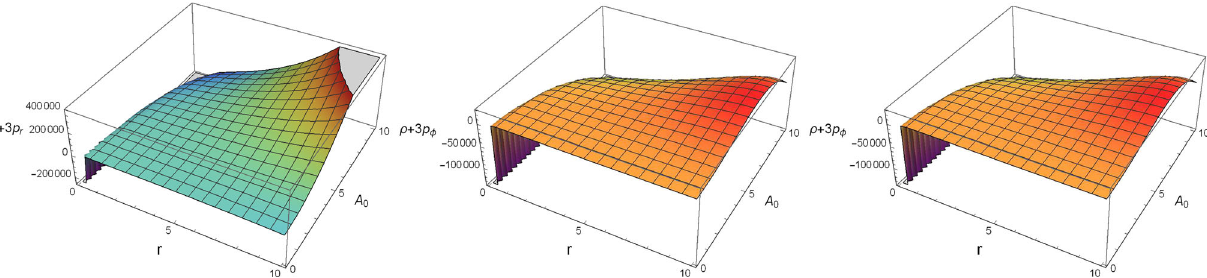
Fig. 15 The graphical variation in this panel shows the behavior of (ρ + 3 p r ) (MeV/fm 3 ) , (ρ + 3 p φ ) (MeV/fm 3 ) and (ρ + 3 p z ) (MeV/fm 3 ) w.r.t r (km) with m = n = 1 and α = − 0 . 01. CASE (D)